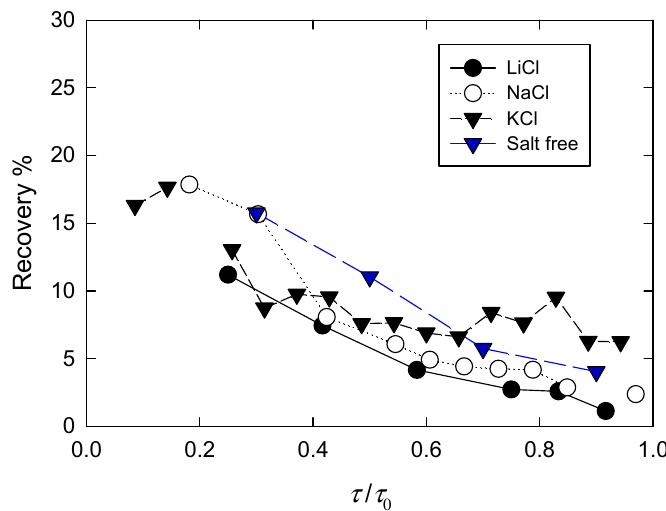
Figure 2. Recovery of suspensions after creep tests of 600 s as function of applied load τ (normalized by yield stress τ 0 ) and different salts (0.5 M).